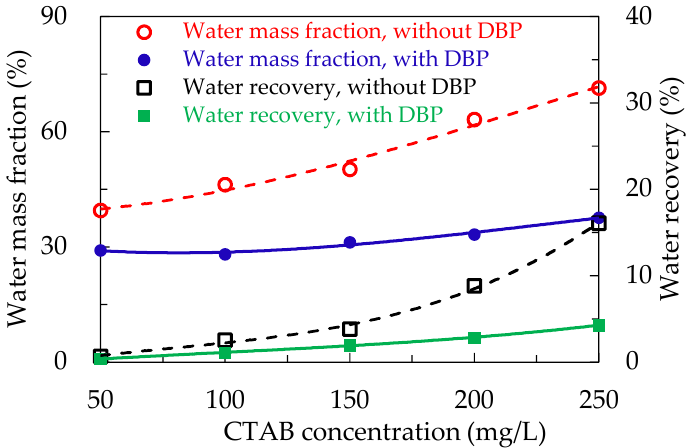
Figure 7. Water mass fraction and water recovery in froth product as a function of CTAB concentration with and without DBP.